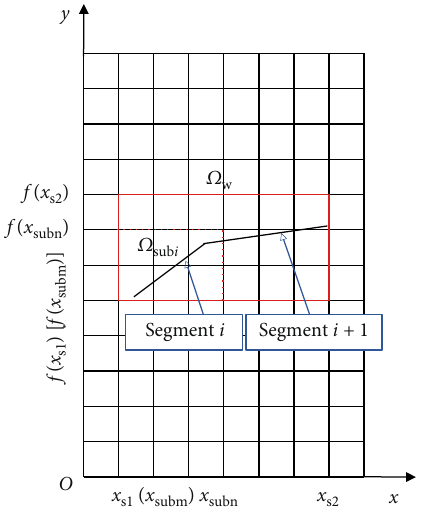
Ω w , sub i , and segments